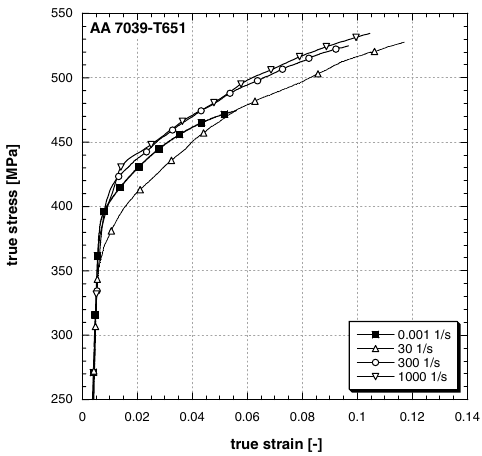
Fig. 9. True stress versus true strain at di ff erent strain-rates for AA 7039-T651.